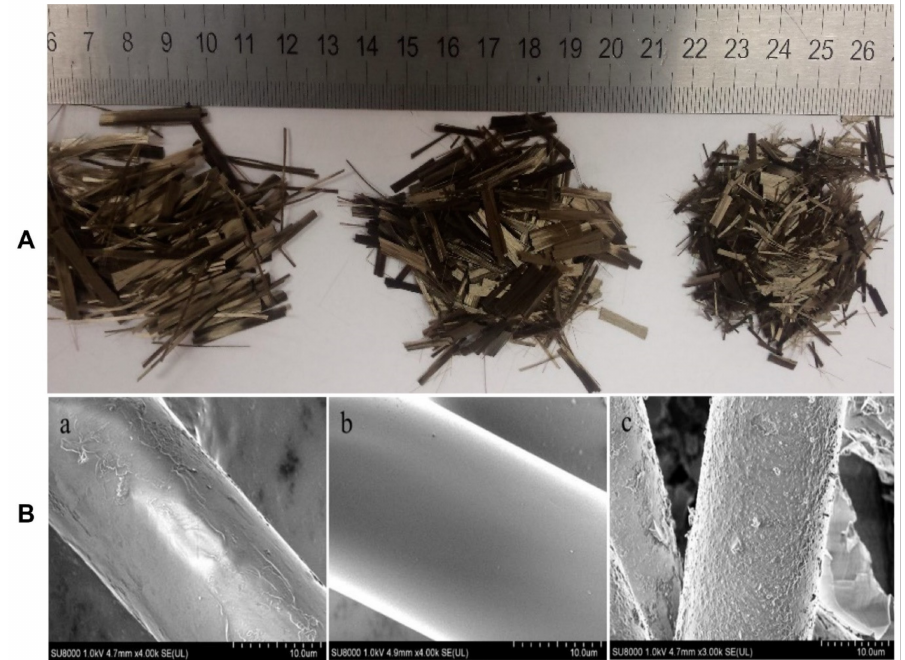
Figure 15. ( A ) Different types of chopped basalt fibers from left to right: With fiber length of 24 mm, 12 mm and 6 mm, respectively, ( B ) morphologies of basalt fibers ( a ) untreated, ( b ) HCl treated and ( c ) NaOH treated. Reprinted with permission from Refs. [165,166]. Copyright 2021, with permission from MDPI and